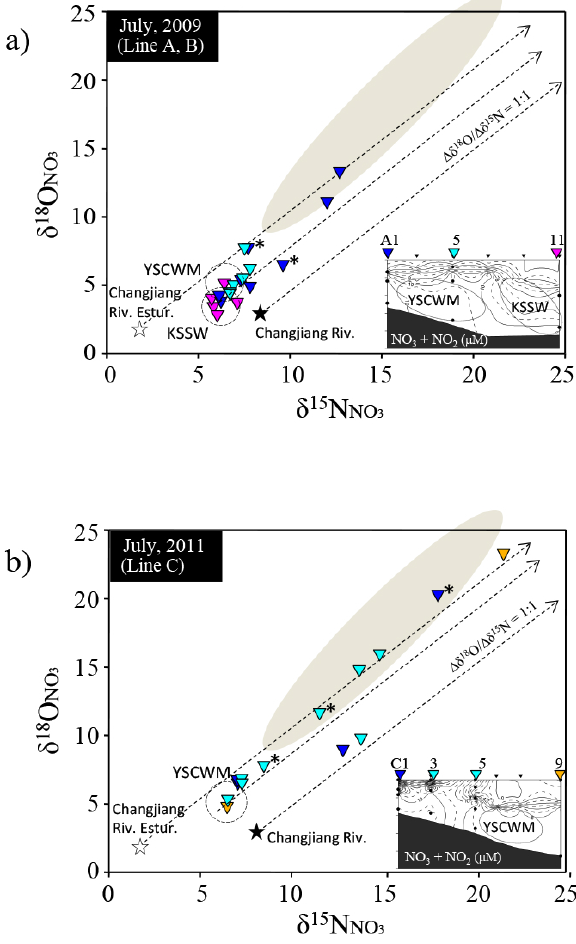
Fig. 5. Relationship between δ 18 O and δ 15 N in nitrate collected at each location along (a) transects A and B in July 2009 and (b) transect C in July 2011. The symbols and lines in the figure are the same as in Fig. 4. The cross section of transect B is